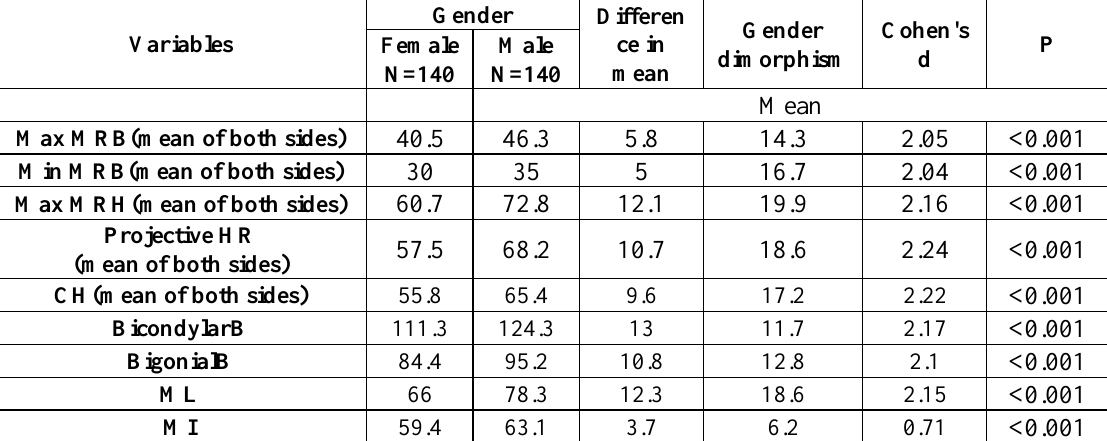
Table 3: The gender differences in mean of bilateral linear mandibular ramus measurements Gender Variables